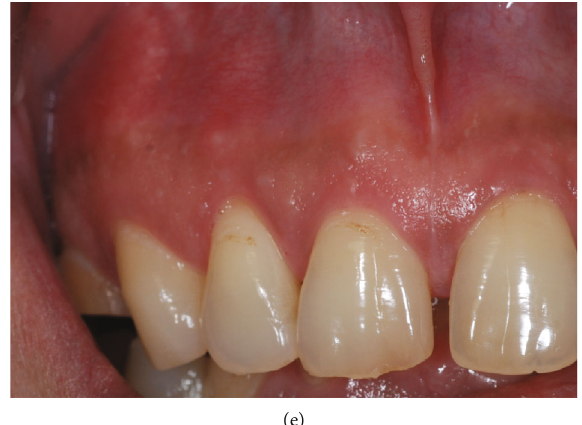
Figure 3: Postoperative intraoral radiographs and photograph. Intraoral radiograph of the maxillary fi rst premolar just after root canal fi lling (a). Intraoral periapical radiograph of the maxillary right central and lateral incisors after 6-month period from the retreatment of only the fi rst premolar; the radiolucent regions tended to heal (c). Intraoral periapical radiograph of the maxillary fi rst premolar and incisors after a three-year period: the radiolucent region of the premolar was healing. The retreatment of the root canal of the second premolar and fi rst and second molars were realized (b), and the radiolucent regions of incisors had almost disappeared (d). Intraoral photograph of right central and lateral incisor after three years